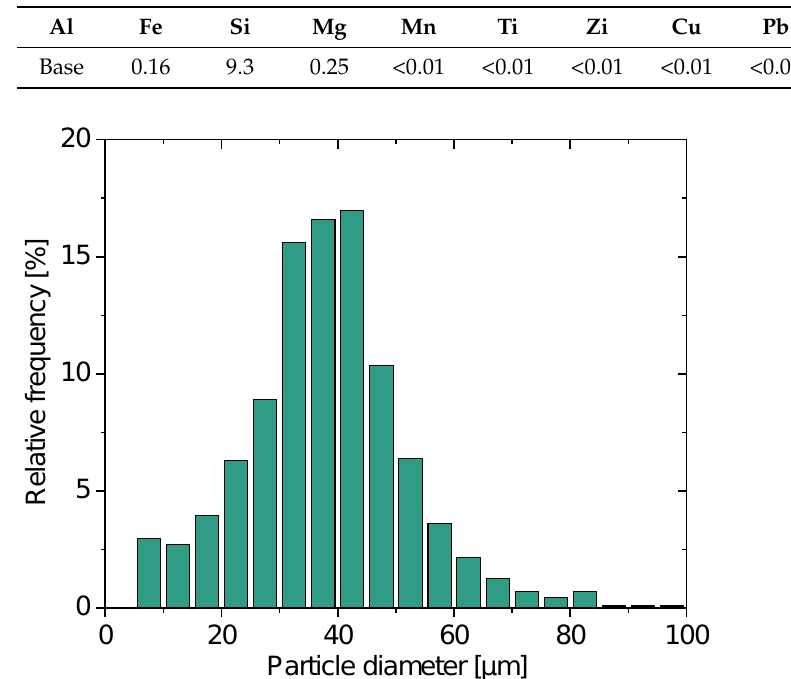
Table 1. Chemical composition of the AlSi10Mg powder particles in wt.%.